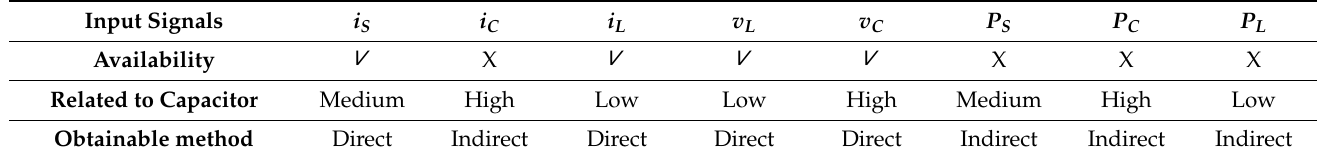
Table 4. Comparison of input signals.